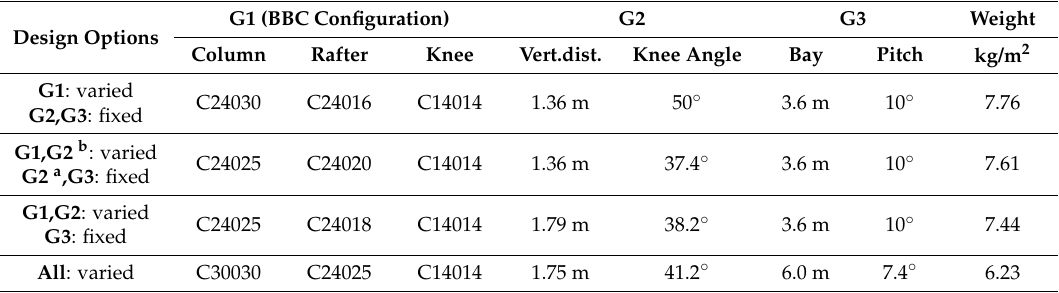
Table 2. Optimum design of Benchmark Frame with rigid joint at